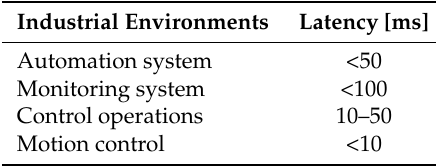
Table 3. Real-time requirements in different industrial environments